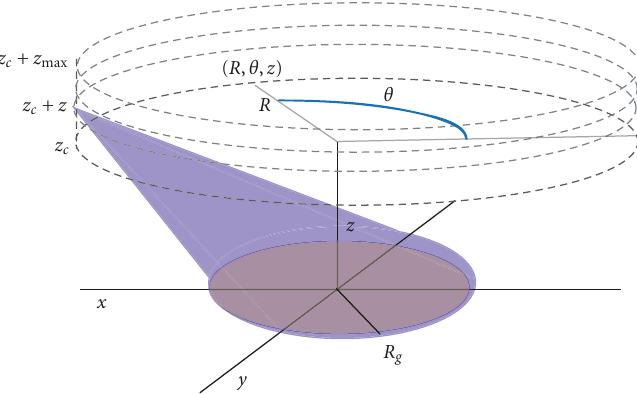
Figure 1: E-CSAR scan geometry.